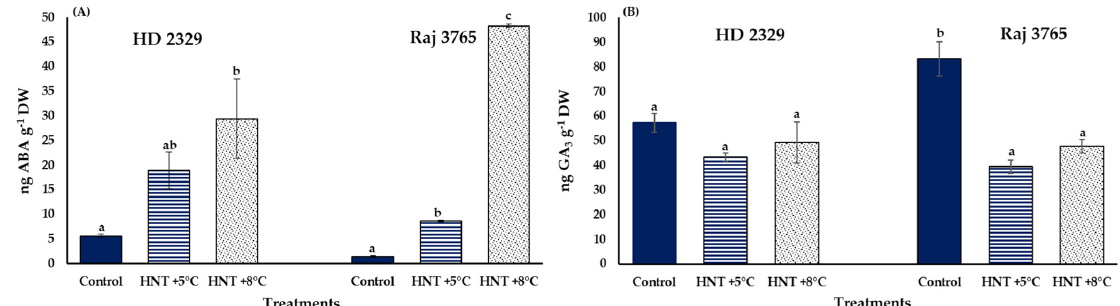
Figure 11. Effect of HNT on the concentration of ( A ) ABA and ( B ) GA 3 in the pistils of wheat genotypes HD 2329 (sensitive) and Raj 3765 (tolerant) under control, HNT (+5 °C) and HNT (+8 °C) conditions. Bars represent mean ± SE. Bars with common letter are not significantly different between temperature treatments in a genotype at p <